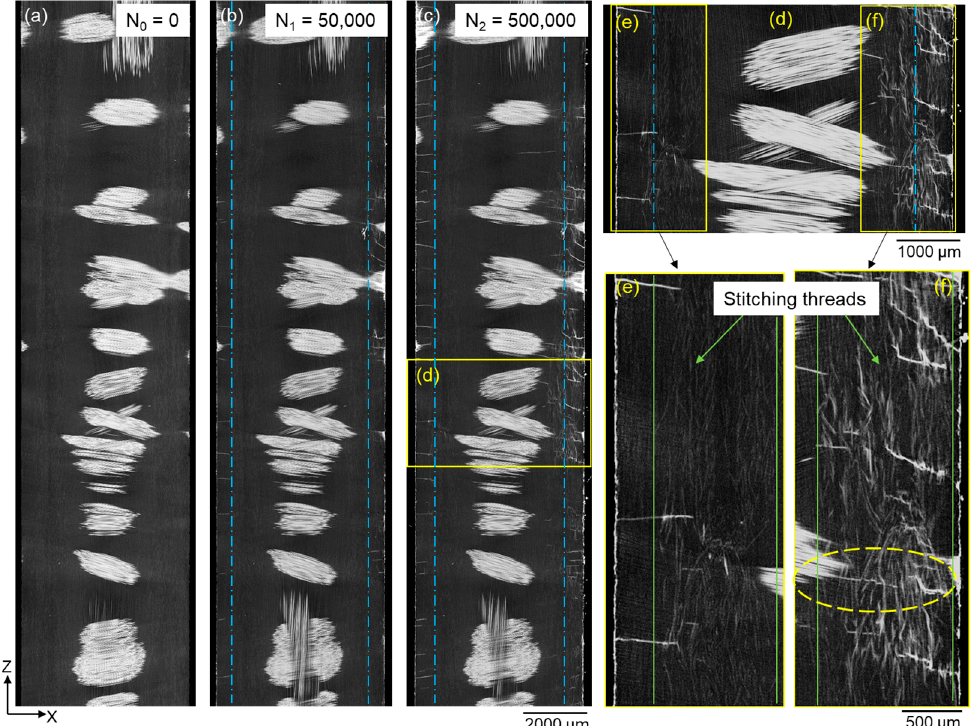
Figure 4. X-ray CT virtual XZ-1 section (position indicated in Figure 3c) of the sample after ( a ) 0, ( b ) 50,000 and ( c ) 500,000 cycles showing the evolution of off-axis matrix cracks initiated from specimen edges. ( d ) Magnified view of the highlighted region in ( c ) showing the off-axis matrix cracks in relation to stitching threads. ( e , f ) Magnified views of the highlighted regions in ( d ) showing the polymer stitching threads (light grey) and stained debonding along stitching threads (white). Dashed blue lines indicate the front of off-axis cracks and solid green lines mark the column where the stitching threads are located